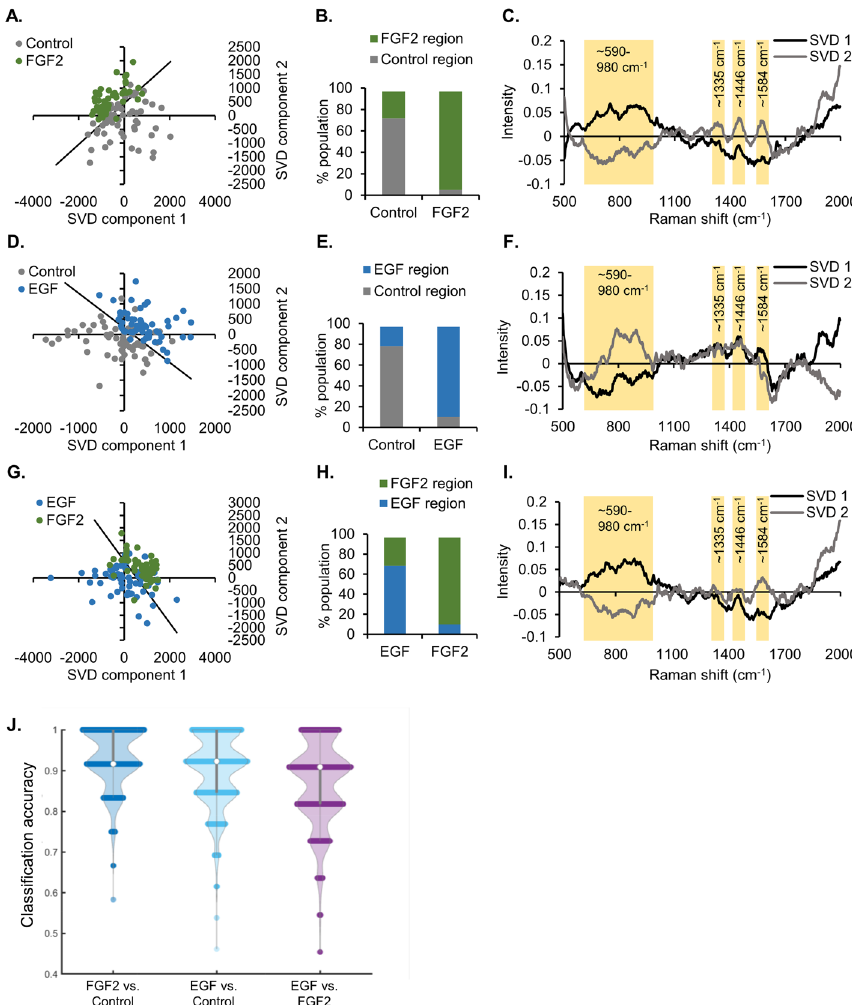
Fig. 4 Multivariate and machine learning analysis of Raman spectra from fixed organoids facilitates separation of untreated and EGF- and FGF2-treated organoids. A–I Multivariate SVD analysis of data from Fig. 3 with control versus FGF2 ( A – C ), control versus EGF ( D – F ), and EGF versus FGF2 ( G – I ). For each comparison, there is an SVD plot where each dot represents a single spectrum, with clustering of similar spectra ( A, D, G ). A line in each SVD plot is placed perpendicular and equidistant to the mean of each treatment to separate the treatments in an unbiased manner. The distribution of the spectra in each region is plotted in B , E , and H , while the SVD components producing the distribution are plotted in C , F , and I . Select regions of interest within the component graphs are highlighted in yellow ( n 50 separate spectra collected = from a minimum of three independent organoids, representative experiment). J Classification accuracy of machine learning (RSVM) on fixed Raman organoid mixed datasets, as indicated, and displayed as a violin plot (120 spectra per comparison; standard deviation less than 0.10 for all